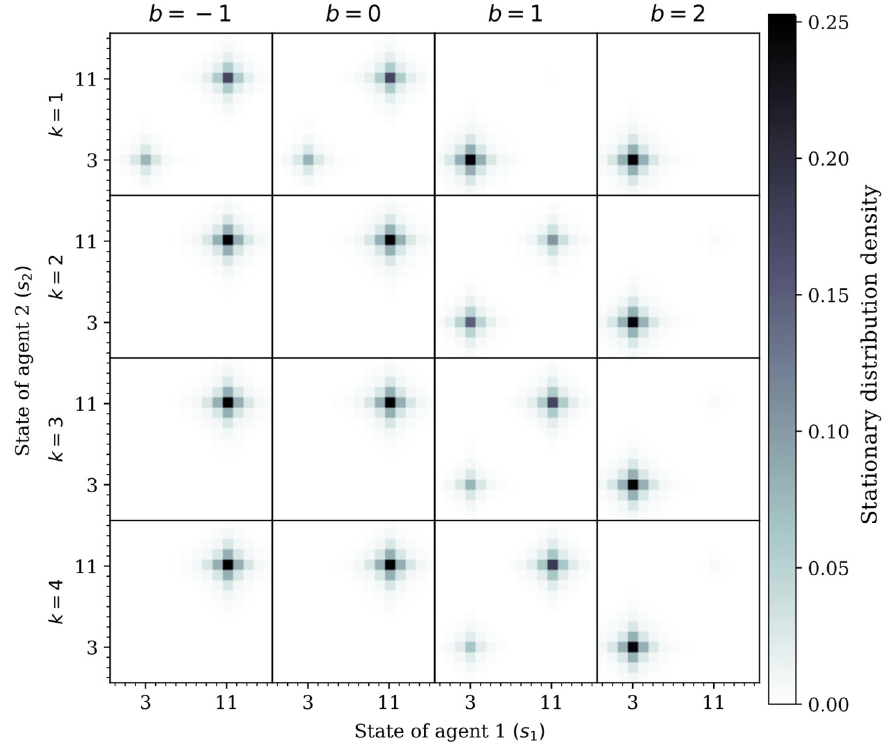
Fig 8. Role of the reference point of CPT-agents in the stationary distributions of the Markov stag hunt game for several sophistication levels. Stationary distributions of the resulting Markov chains obtained by conditioning the Markov game to increasingly sophisticated policies, k = 1, 2, 3 and 4, for CPT-agents with several reference points b = − 1, 0, 1, 2. Darker colors indicate higher probability. We assumed discount factors β 1 = β 2 = 0.9, utility function u ( x ) = x , and weighting function w ð x Þ ¼ e (cid:0) 0 : 5 ð(cid:0) log ð x ÞÞ 0 : 9